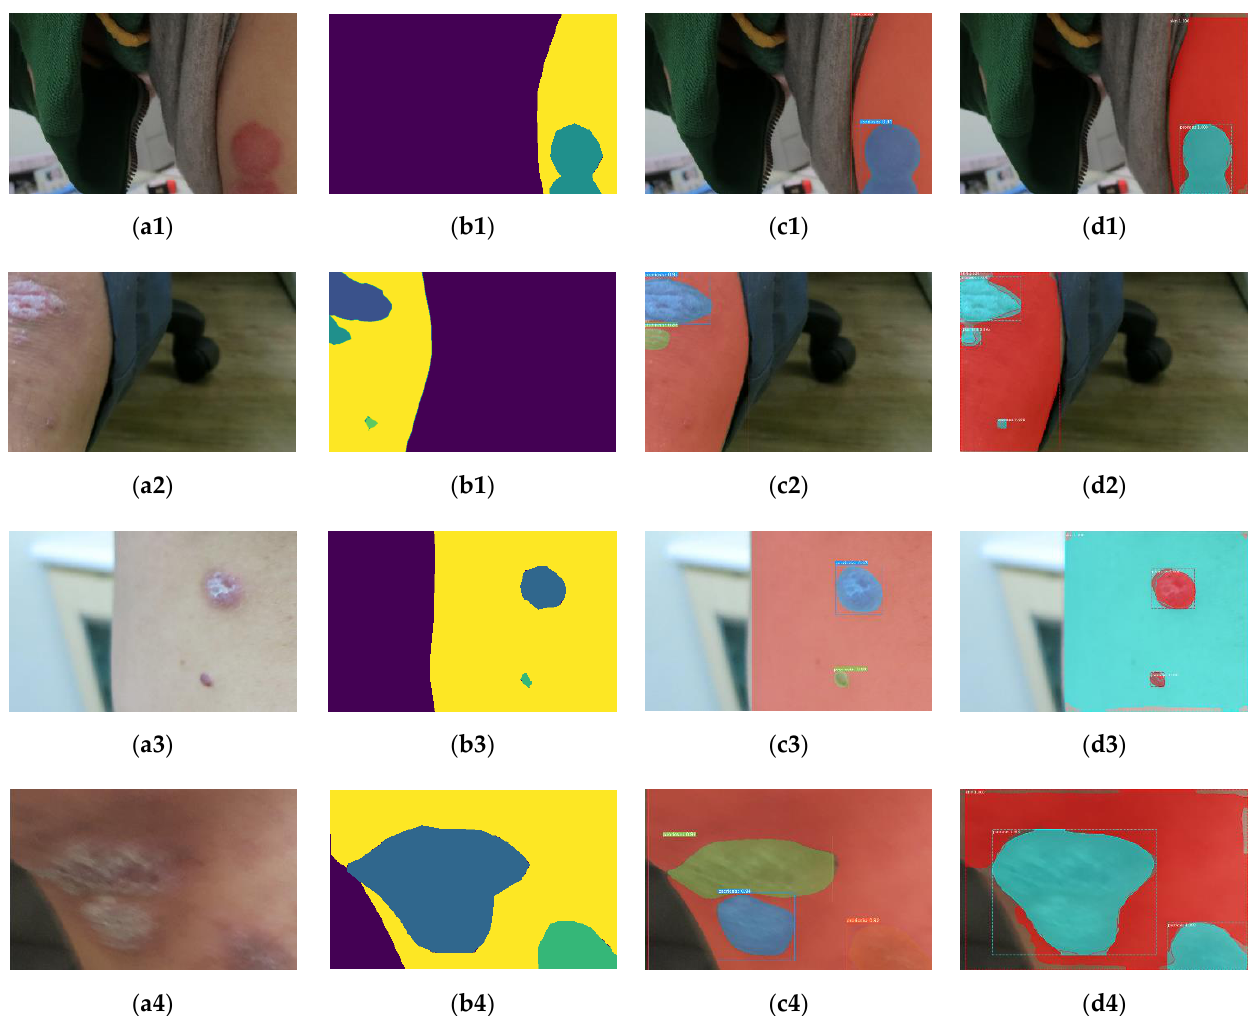
Figure 7. Instance segmentation results: ( a1–a4 ) Input, ( b1–b4 ) ground truth, ( c1–c4 ) proposed, and ( d1–d4 ) Mask R-CNN.